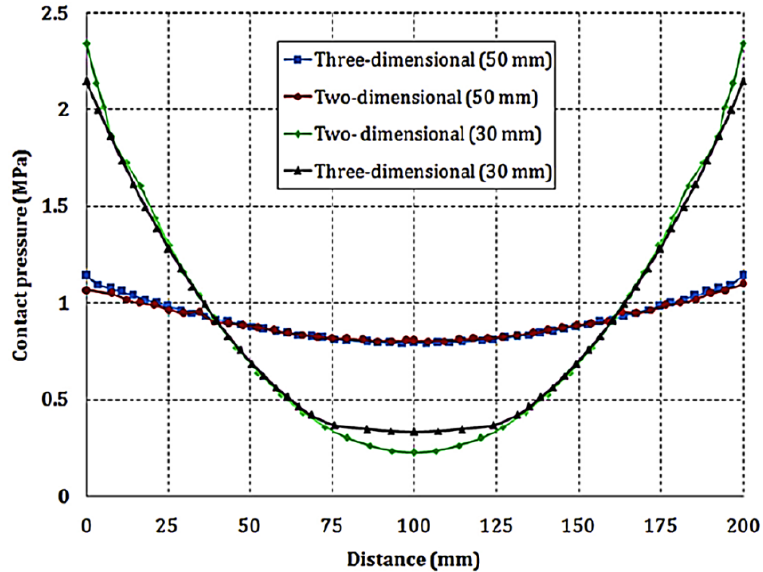
Figure 8. Contact pressure distribution on varying cell stacks [145] (license no.